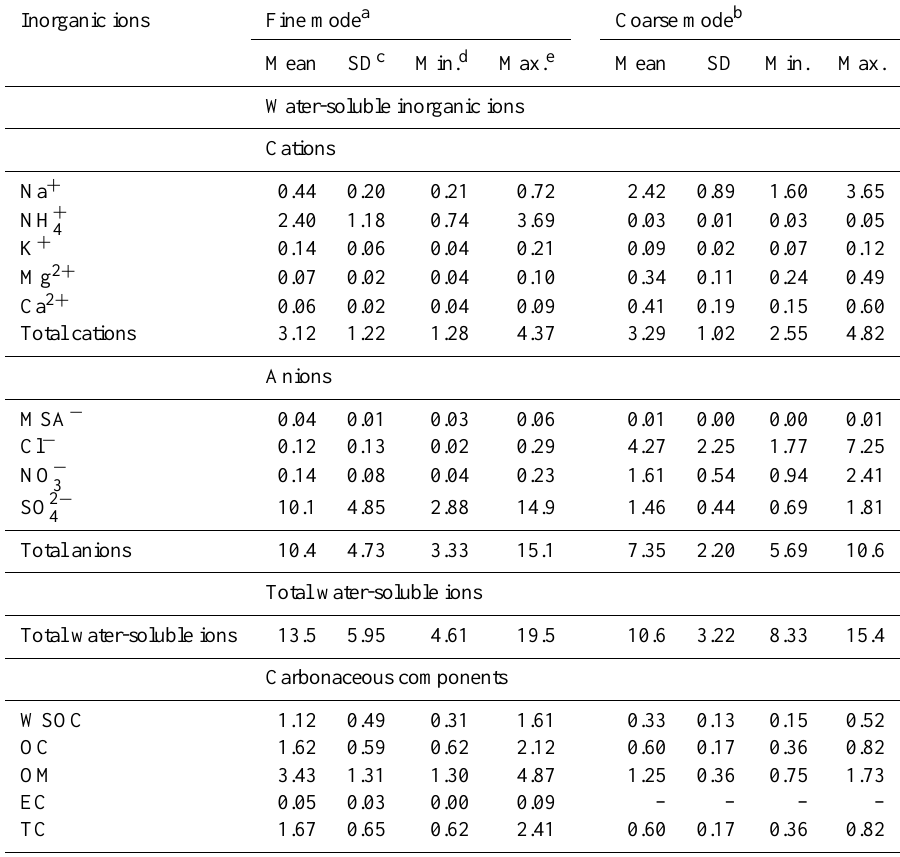
Table 1. Concentrations (µgm − 3 ) of major inorganic ions and carbonaceous species in the fine- and coarse-mode aerosols on Okinawa Island in the western North